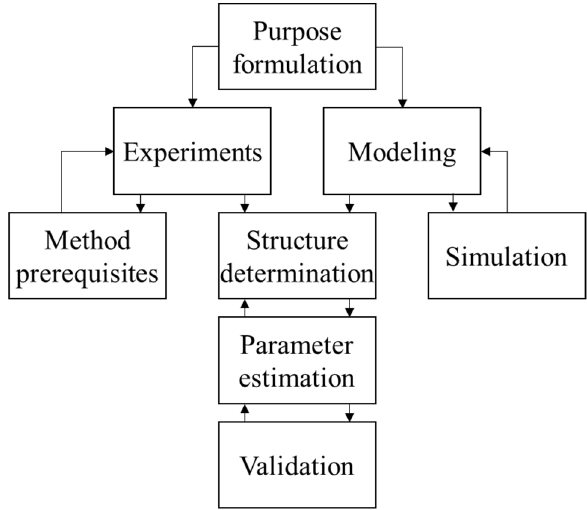
Figure 1. Procedures of system identification.